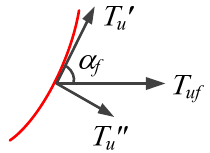
Figure 10. Resolution diagram of the ultimate bearing capacity of the anchor-plate.